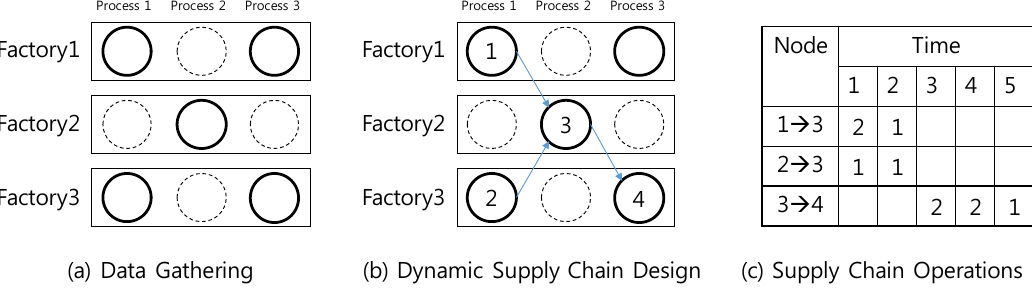
Figure 3. Dynamic supply chain design and operation.